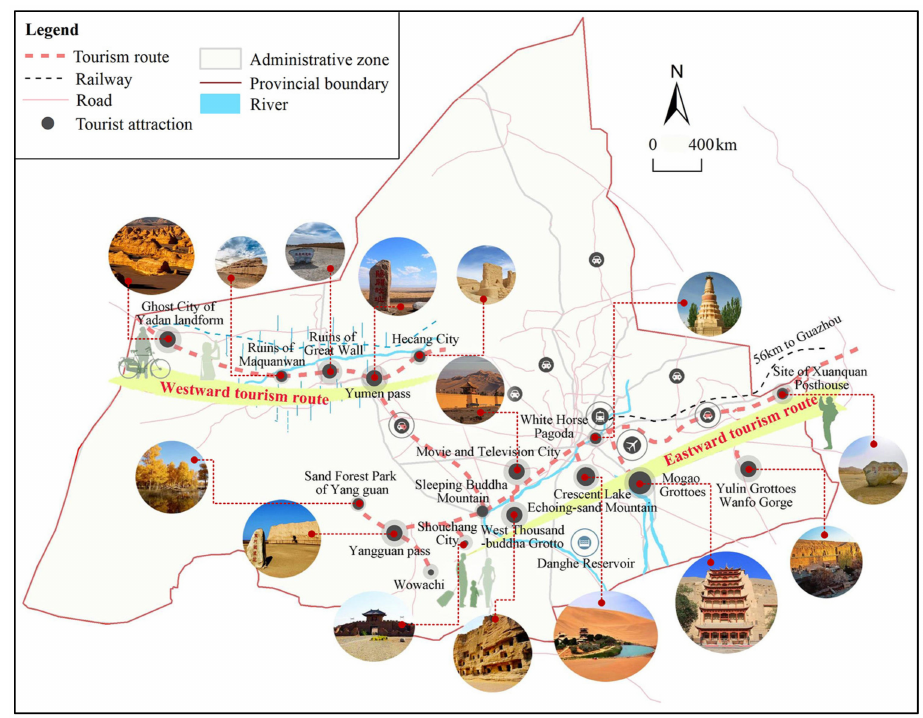
Figure 3. The spatial distribution of tourism resources and routes in